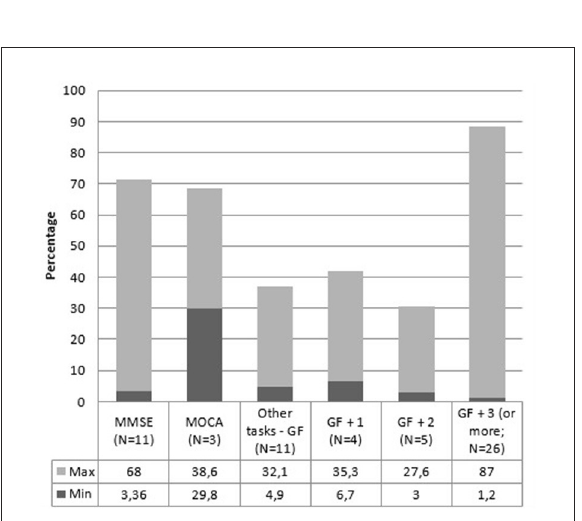
FIGURE6 MCI prevalence range according to the number of assessed cognitive domains. MMSE, Mini-Mental State Examination; MoCA, Montreal Cognitive Assessment; GF, global functioning;